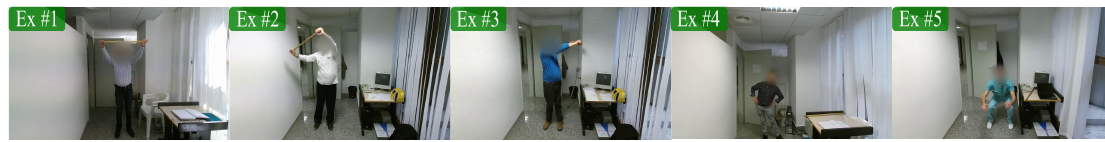
Figure 4. Sample frames of KIMORE for five different exercises.